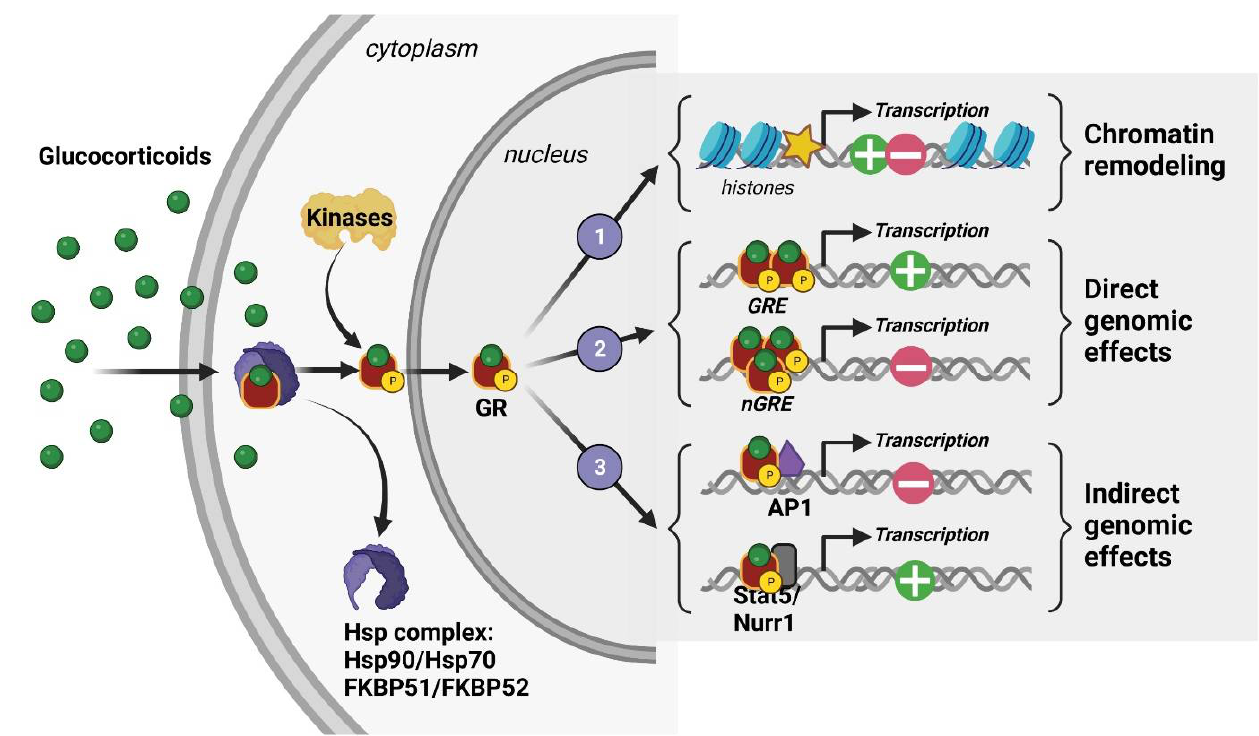
Figure 3. Molecular mechanisms of action of a glucocorticoid receptor (GR).